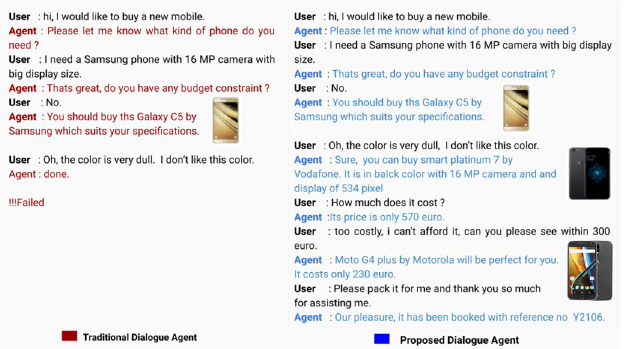
Fig 1. Performance of a traditional dialogue agent and our proposed agent in dynamic goal setting scenario.